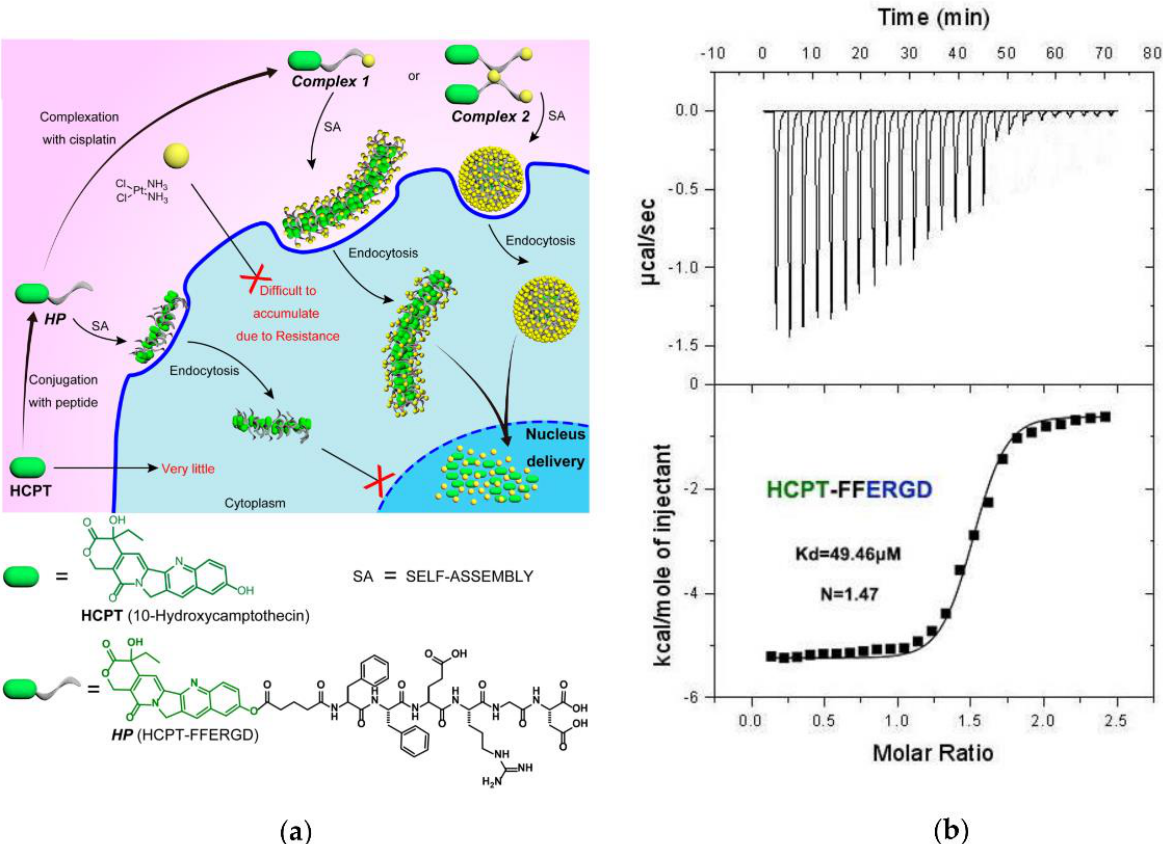
Figure 1. ( a ) Schematic illustration of the preparation of dual-drug assemblies and nuclear drug delivery (above); chemical structures of HCPT and HP (below). ( b ) ITC titration curves of HP with cisplatin. Figure adapted with permission from reference [47]. Copyright 2017 American Chemical